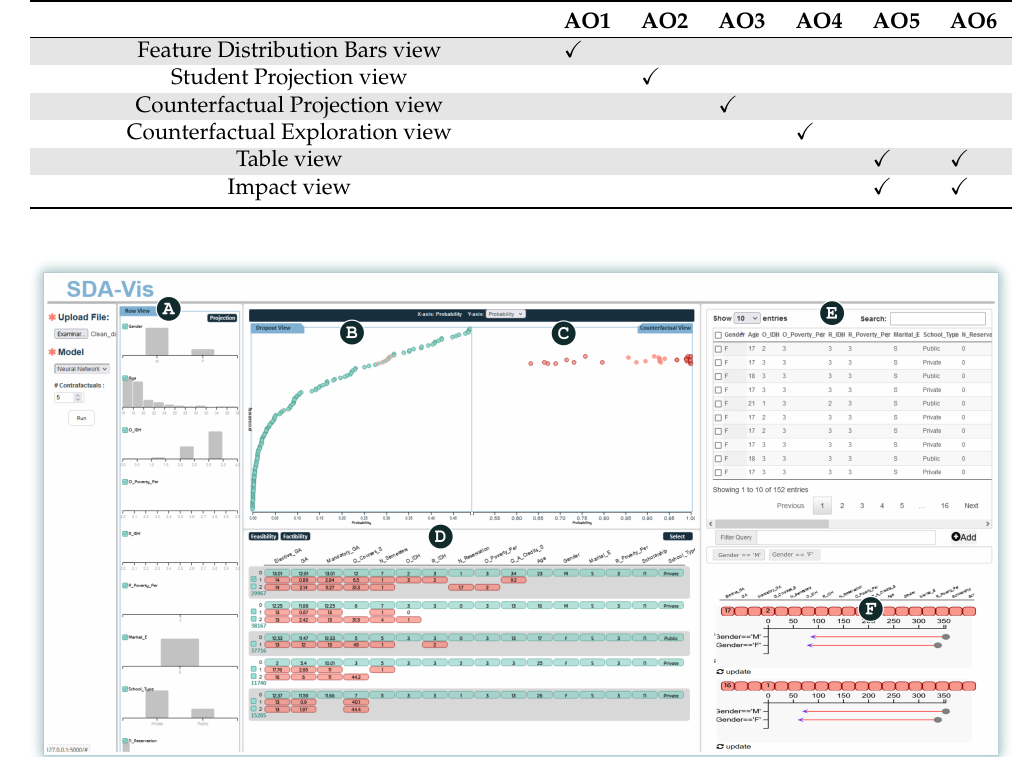
Figure 3. SDA-Vis system: a set of linked visual resources enabling the exploration of dropout students’ information and their counterfactual explanations. A Feature Distribution Bars view, B Student Projection view, C Counterfactual Projection view, D Counterfactual Exploration view, E Table view, and F Impact